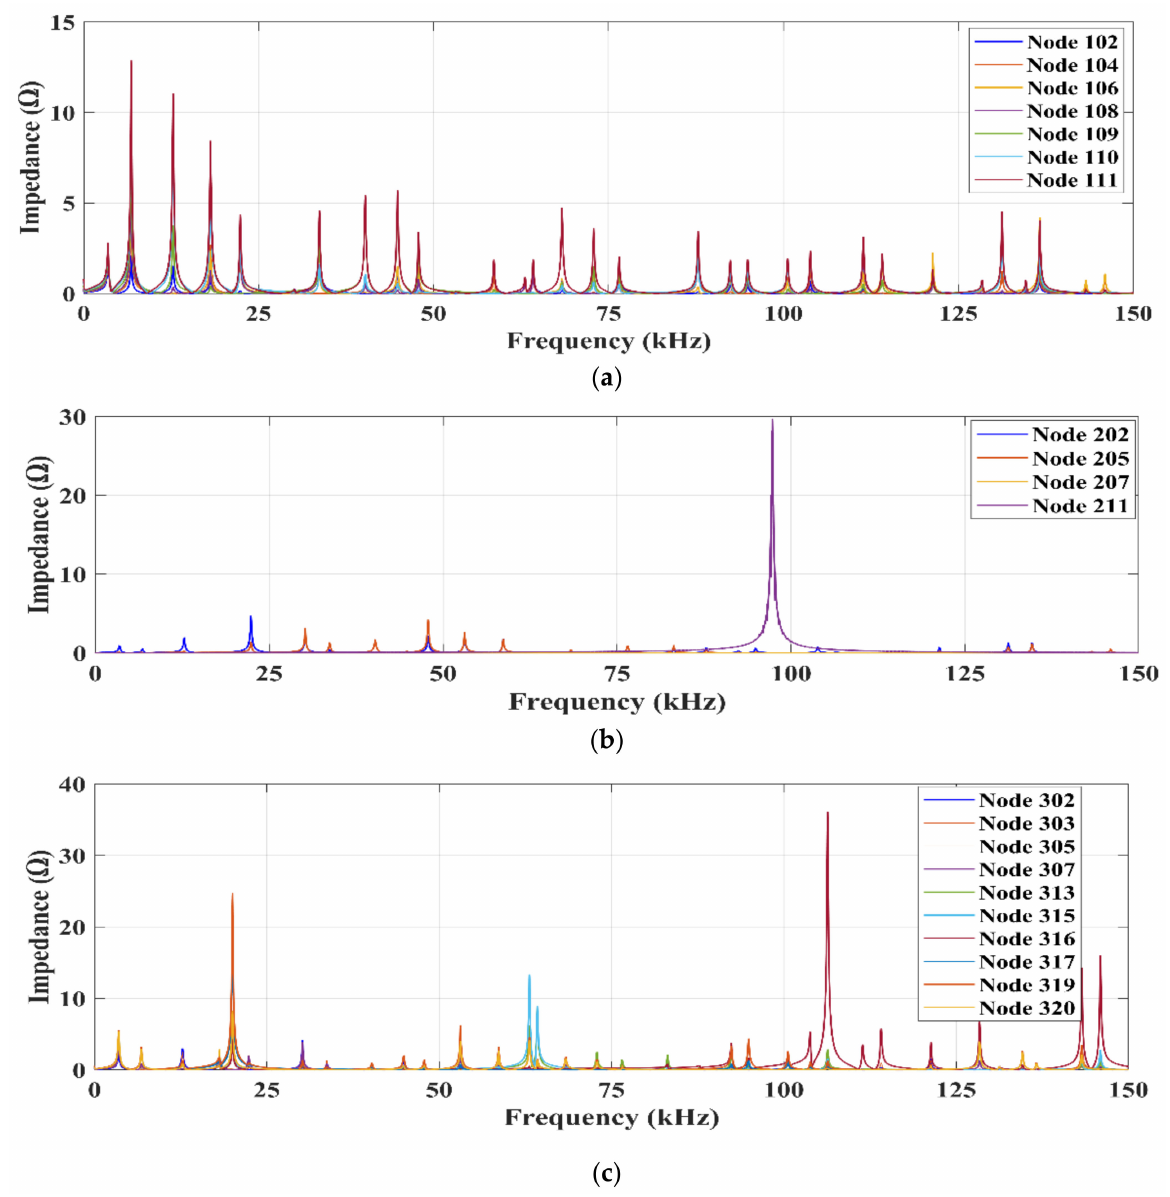
Figure 6. Driving point impedance of test network at medium voltage (MV) side of distribution transformer ( a ) feeder A, ( b ) feeder B and ( c ) feeder